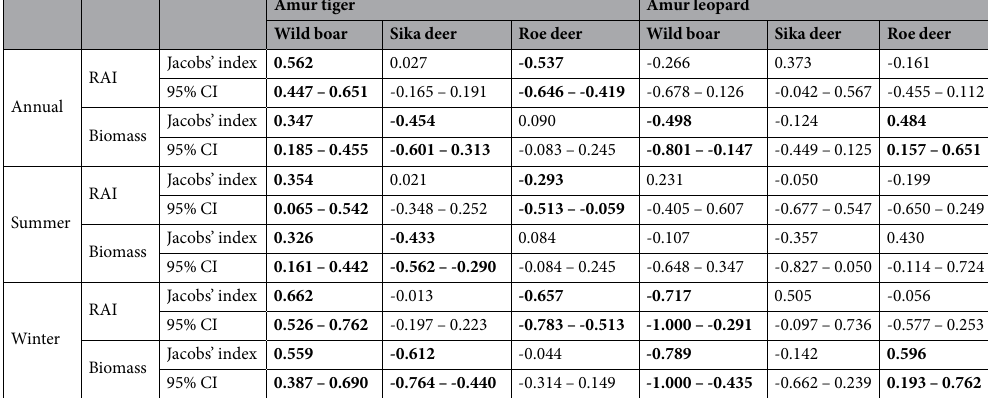
Table 4. Jacobs’ index scores and associated 95% confidence intervals (CI) based on relative abundance index and biomass measuring tiger and leopard annual and seasonal preferences and avoidances for three main prey species in NE China. Note: Tiger and leopard diets were estimated from scats, and relative abundance and biomass were calculated from camera trap data. Confidence interval of each prey item was generated using 10000 bootstrap simulations. 95% CI that do not overlap with zero indicate significant ( p < 0.05) preference or avoidance for a prey